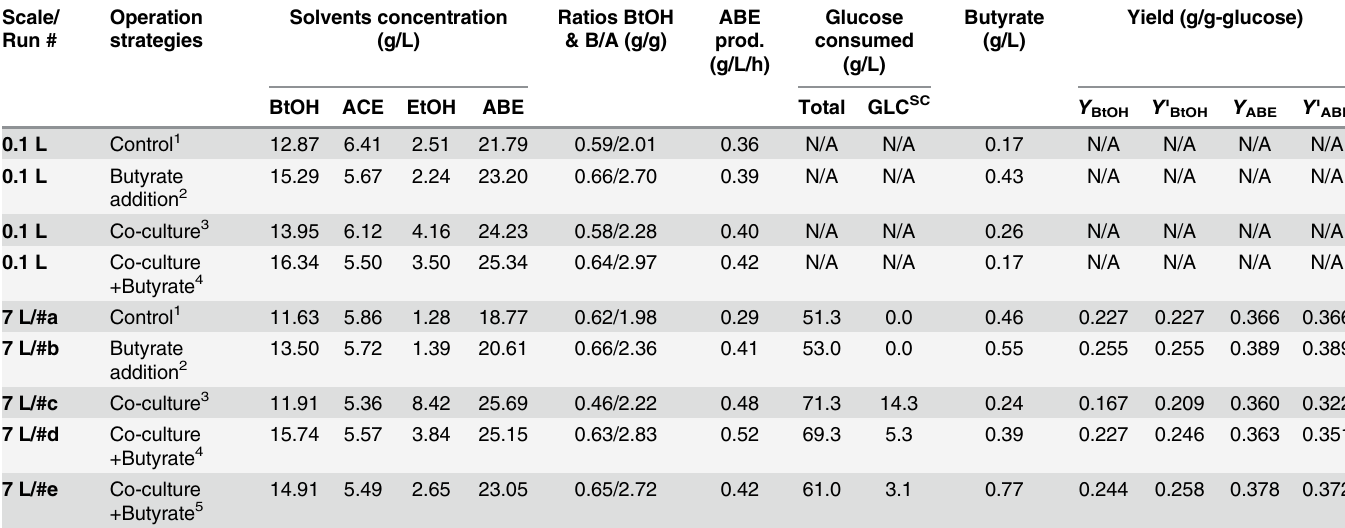
Table 1. Comprehensive performance comparison of ABE fermentation using different operation